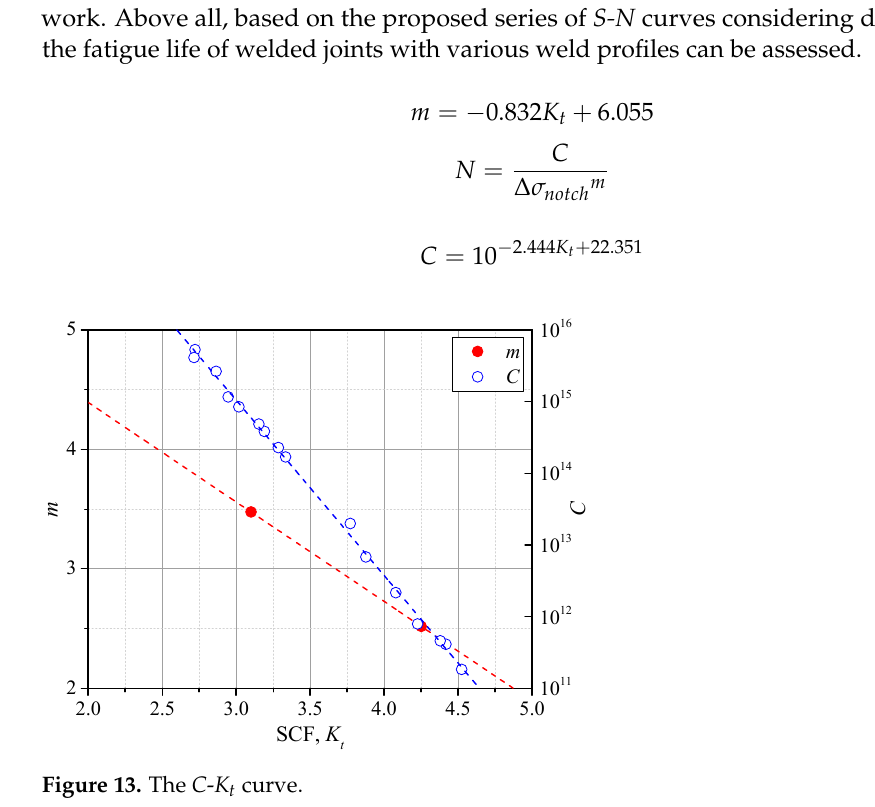
Figure 13. The C - K t curve.